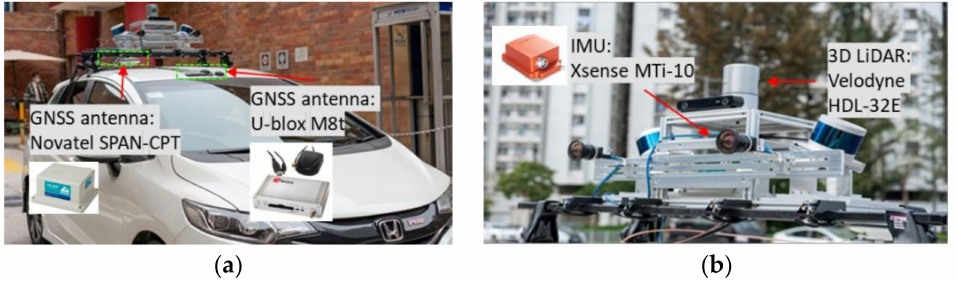
Figure 4. Sensor setup deployment during the experimental data collection. ( a ). GNSS antennas of NovAtel SPAN-CPT and u-blox M8t. ( b ). The Xsens Ti-10 IMU and the Velodyne HDL-32E LiDAR.